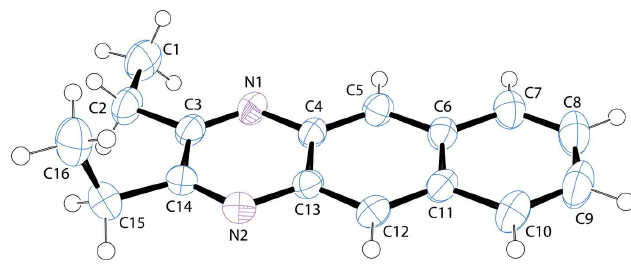
Figure 1 A view of the title compound with displacement ellipsoids drawn at the 50% probability level.